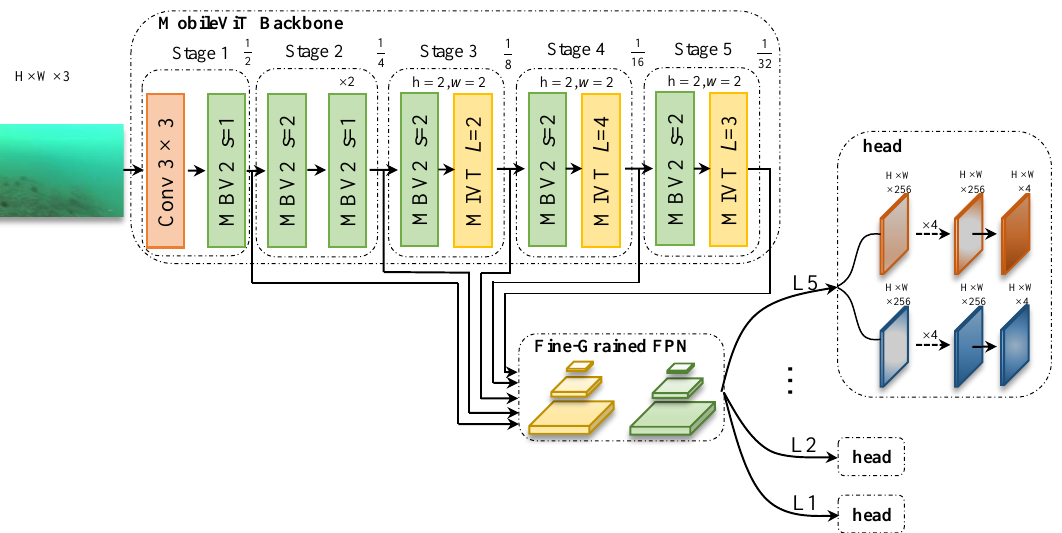
Figure 3. Overview of our detector. The input of the network is a color image with three channels, and the lightweight backbone is applied to extract multiscale features from the input image. A novel fine-grained FPN is applied to get feeble and small object friendly features. The hyperparameter L in the backbone is the repeated times of transformer blocks for each MobileVit module. The s in the MBV2 module is the down-sampling stride number relative to each module’s